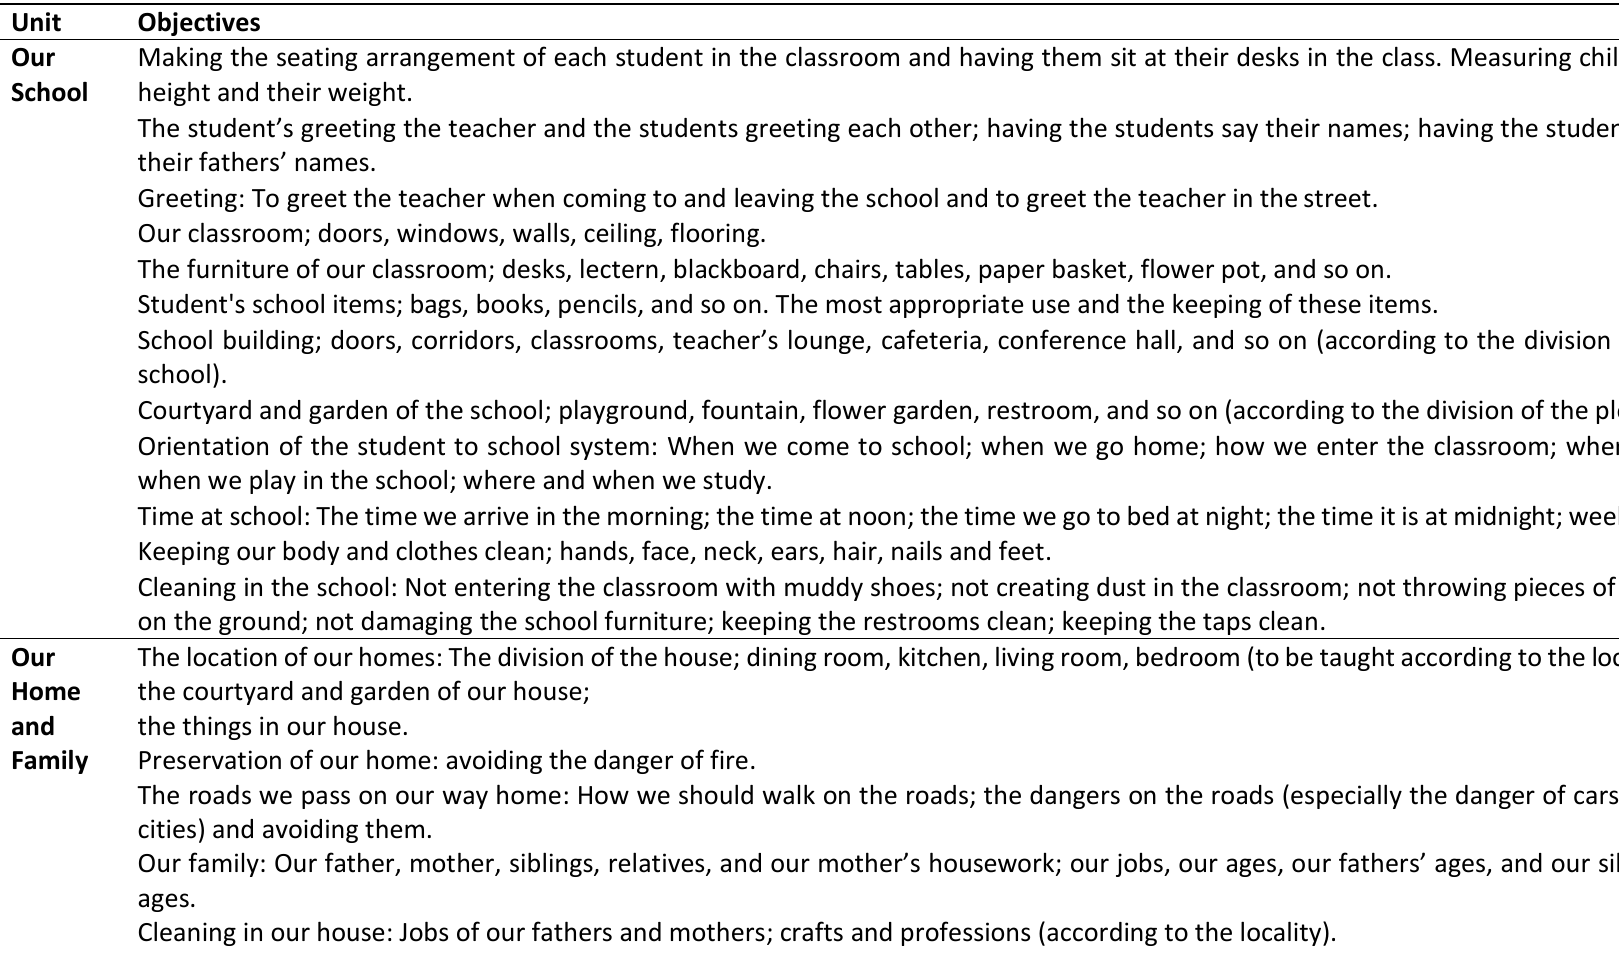
Table 3. Life Studies Curriculum Objectives in the First Grade Unit Objectives